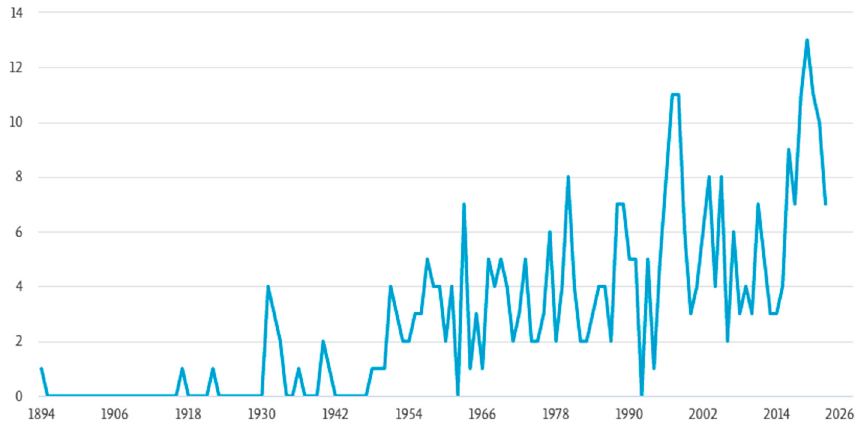
Figure 1. Number of publications per year (ordinate and abscissa axes, respectively) devoted to polyhalides (19 December 2022; Scopus database, search TITLE-ABS-KEY (polyhalide *)—355 examples).